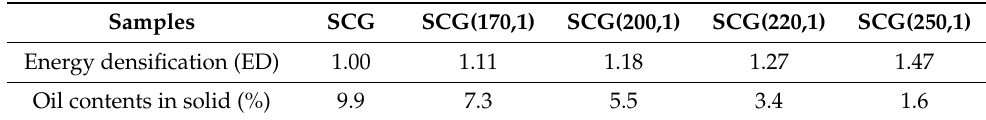
Table 3. SCGs energy density depend on HTC temperatures.